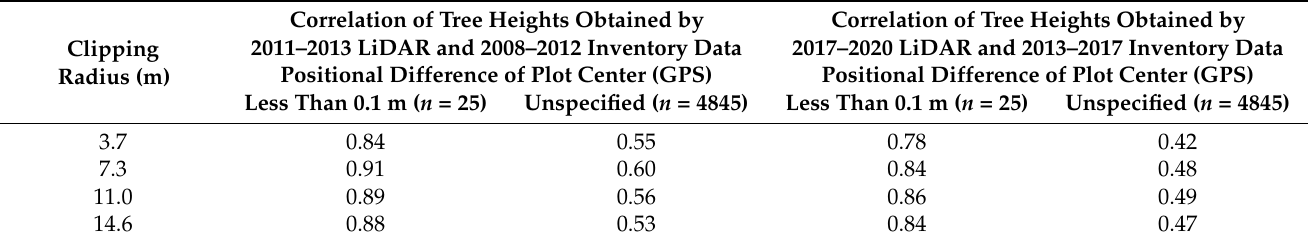
Table 1. Effect of clipping area (radius) and positional difference of plot center location on correlation between LiDAR and inventory height. LiDAR height was obtained from a circular area with variable radii, whereas inventory height was acquired within the original plot area with a 7.3 m radius.